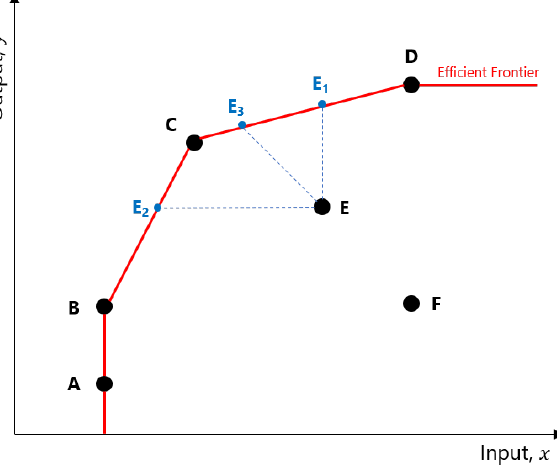
Figure 2. Visualization of a VRS model with a single input and single